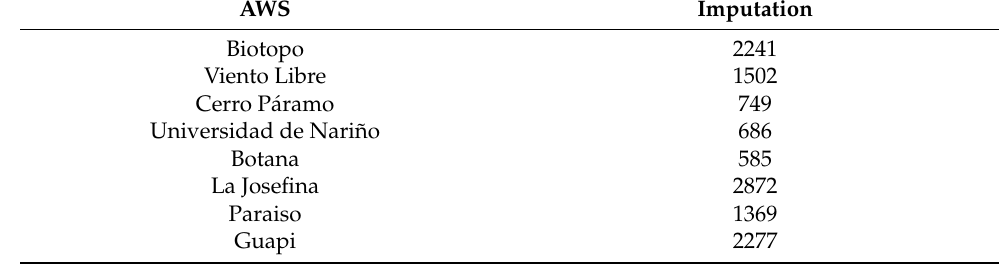
Table 13. Imputation by AWS.